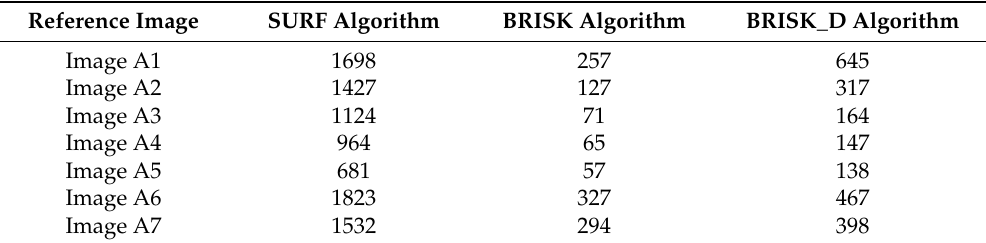
Table 5. The correct matching number of 3 algorithms after image blurring.